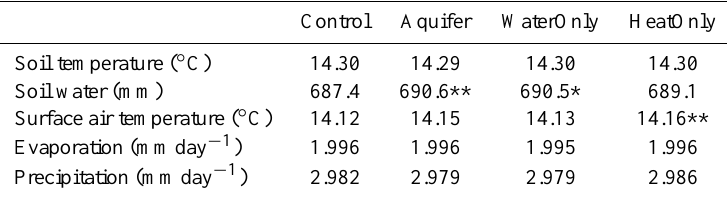
Table 1. Mean of climate variables